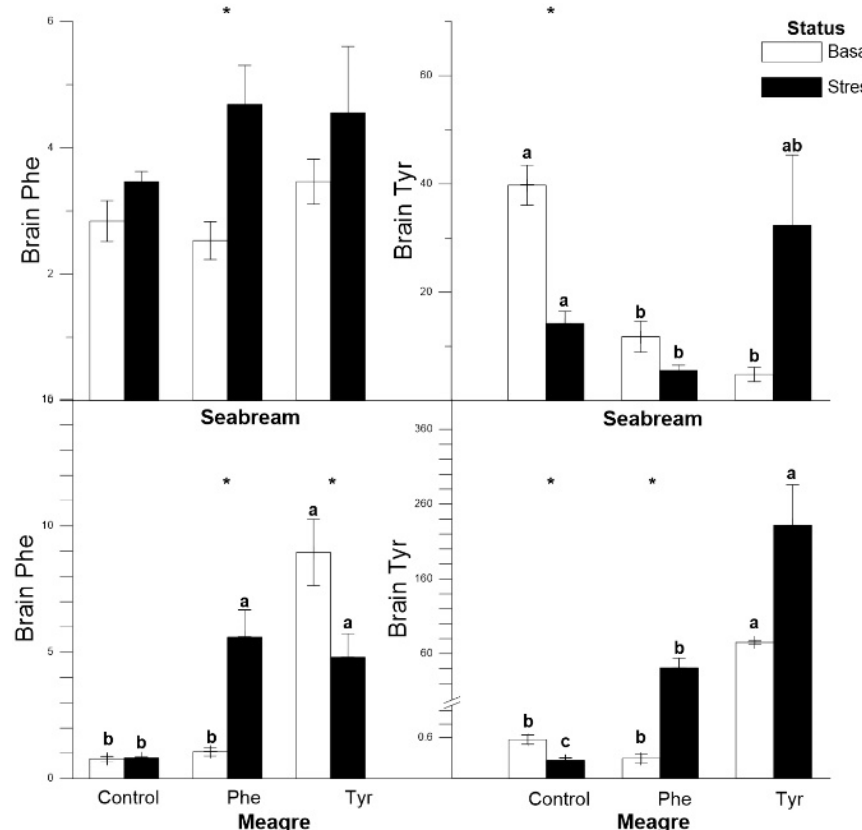
Figure 5. Brain Phe and Tyr concentrations (ng mg − 1 ) for each treatment (mean ± SE, n = 10). The white and black bars are the basal and stress values, respectively. Asterisks indicate significant differences between the basal and stress conditions. Different letters indicate significant differences among feeding treatments within every condition.